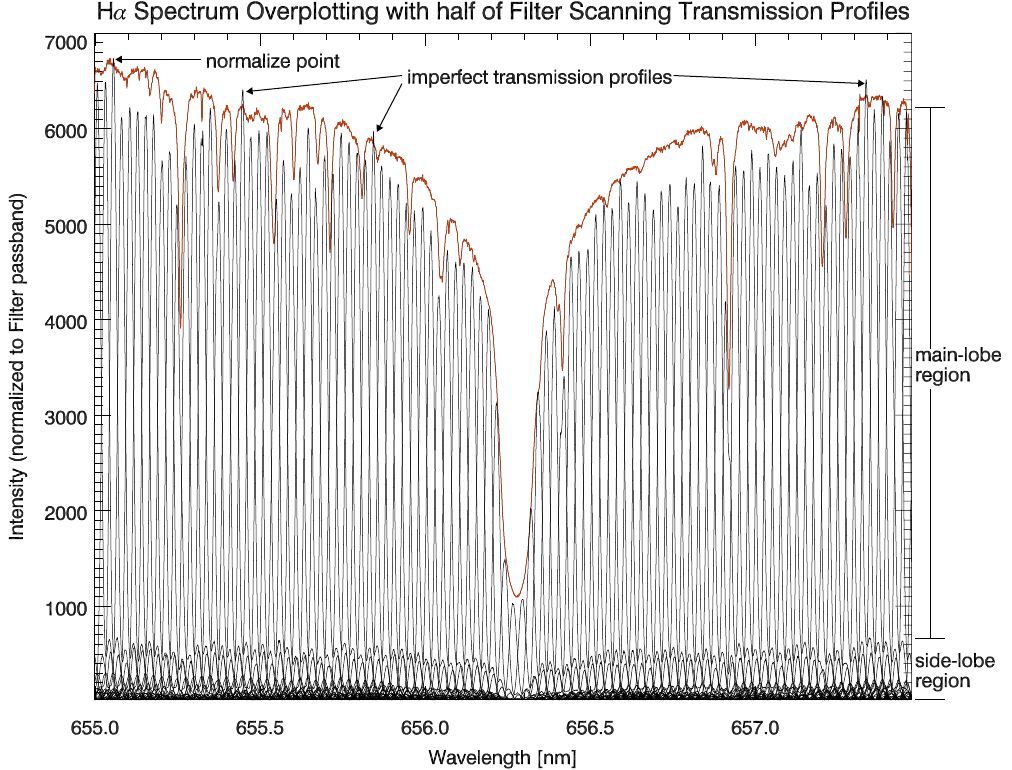
Figure 4. The 101 BF profiles half-sampled from the first data set are plotted together with a solar H α spectrum marked by the red-solid line. All these scanning profiles and this solar spectrum are observed by the same spectrograph system. In a very ideal situation, it could be very close to the red H α spectrum by joining the highest points of these scanning profiles. The results is the same if this reference point is fixed on any point of these scanning profiles. That is the reason why there are many H α -like envelopes formed in side-lobes